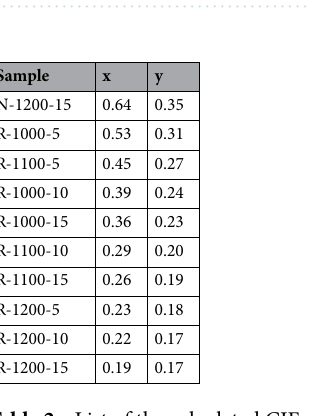
Figure 4. CIE 1931 color space chromaticity diagram with marked samples’ coordinates. Diagram adapted from 37 .